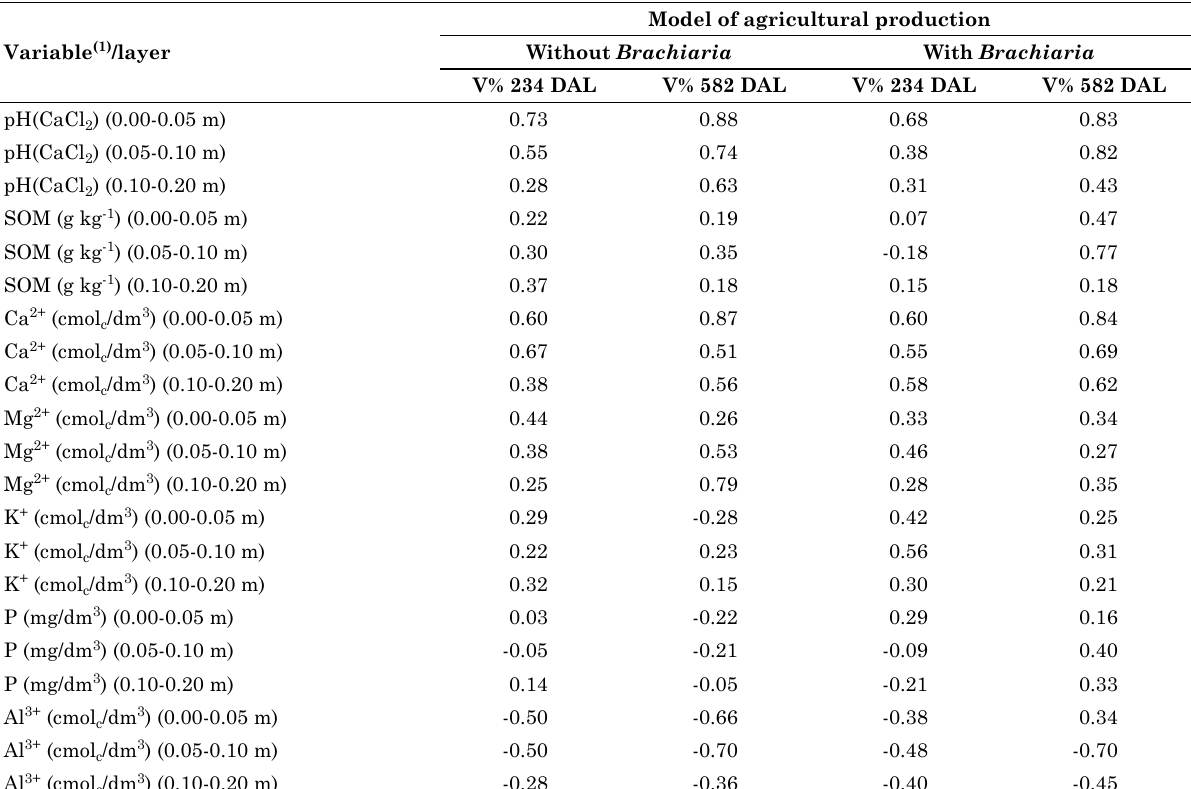
Table 1. Pearson correlation coefficients among soil attributes and model of agricultural production at